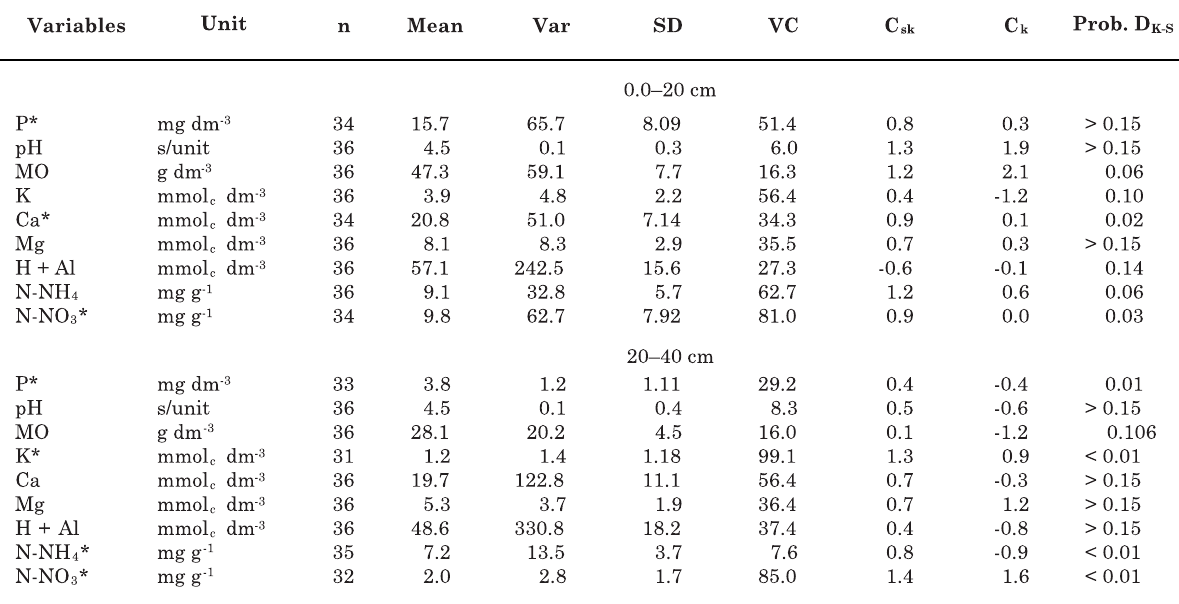
Table 1. Descriptive statistics of soil chemical properties